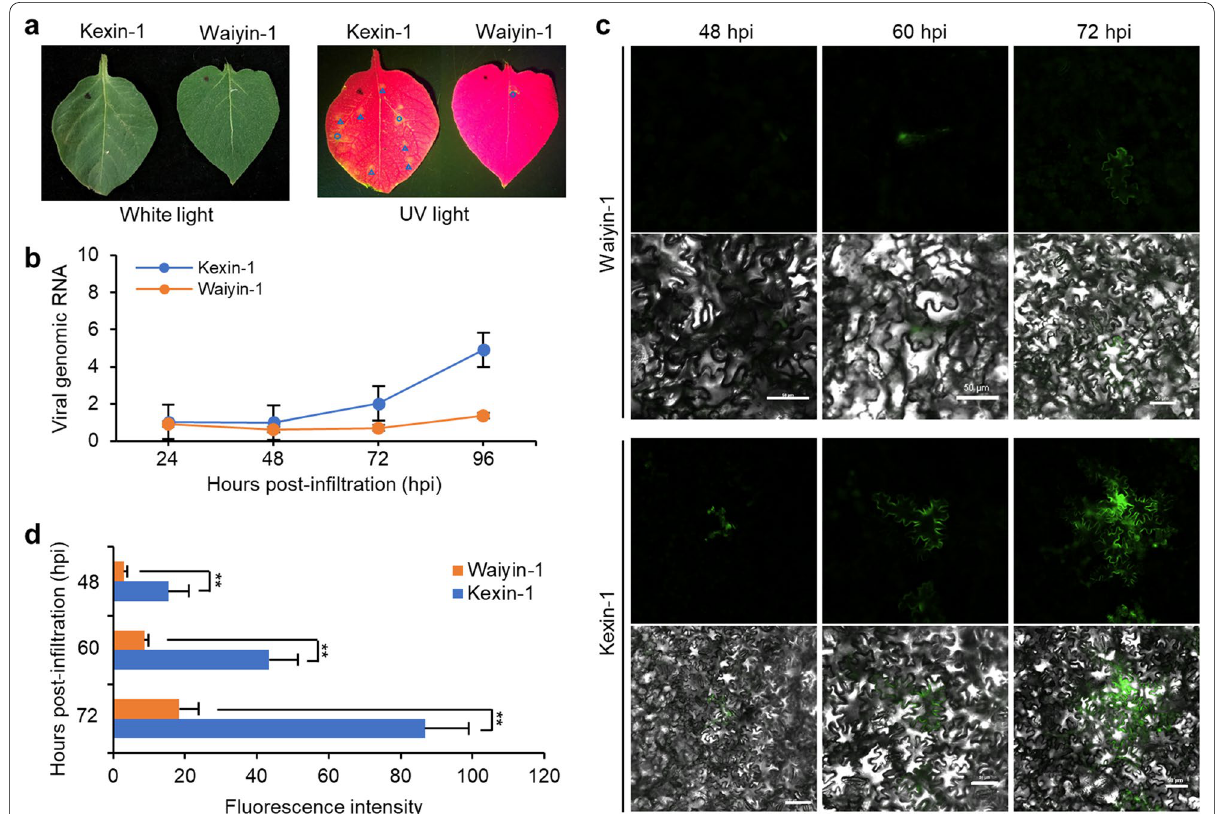
Fig. 4 Waiyin-1 suppresses PVX infection. a Visualization of the infection foci on the leaves of Waiyin-1 and Kexin-1 plantlets sap-inoculated with pGR107-YFP at 10 dpi. Circles, mechanical injuries; triangles, the infection foci. b RT-qPCR analysis of the accumulation of viral genome RNA in Waiyin-1 and Kexin-1 infected with pGR107-YFP. Potato ACTIN 7 was used as an internal control. The genomic RNA level of pGR107-YFP in Waiyin-1 was normalized to 1. Bars represent means s.d. (n 5). c Microscopic observation of the infection of Waiyin-1 and Kexin-1 by pGR107-YFP. d ± = Quantification of fluorescence intensities in the leaves of Waiyin-1 and Kexin-1 infected with pGR107-YFP. Data represent